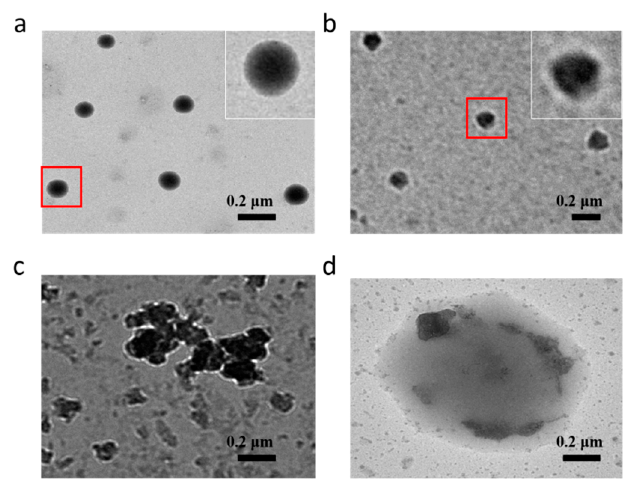
Figure 5. Typical TEM images of ( a ) polymer 3 micelles, ( b ) DOX-loaded polymer 3 micelles, ( c ) polymer 3 micelles in PBS (10 mM DTT), and ( d ) DOX-loaded polymer 3 micelles in PBS (10 mM DTT).